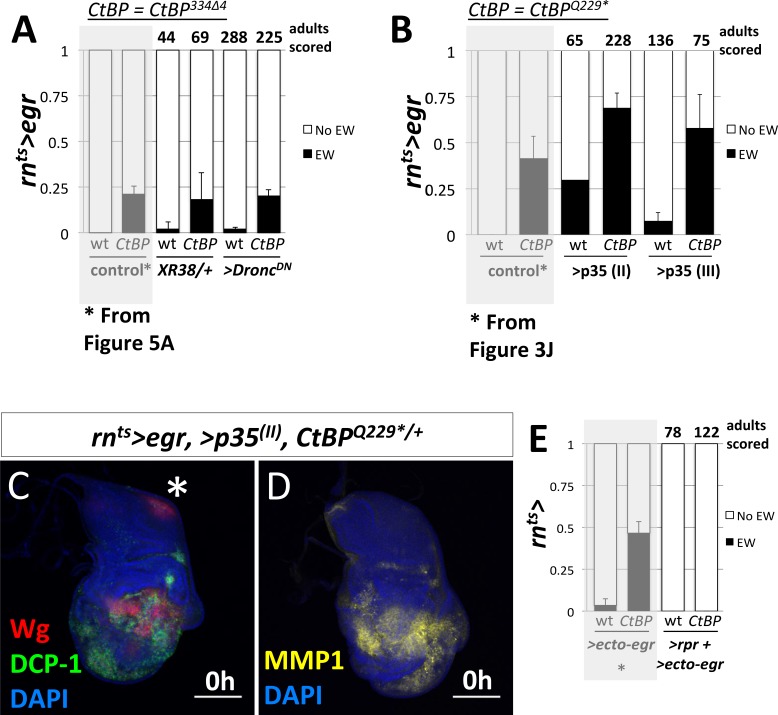
Manipulations of apoptosis levels during the damage period.(A) Frequency of ectopic wings (EW) following rnts>egr damage in wild type or CtBP334Δ4/+ in listed genotypes: (1) Df(3L)XR38/+ and (2) co-expression of UAS-DroncDN. Same controls as shown in Figure 5A. (B) Frequency of EW following rnts>egr damage in wild type or CtBPQ229*/+ with the co-expression of UAS-p35, by transgenes inserted on chromosome 2 and 3. Same controls as shown in Figure 3J. (C, D) Wing imaginal discs following rnts>egr damage with co-expression of UAS-p35. Note that there is still a high level of apoptosis (DCP-1), and Wg pattern disruption (C) and JNK activity visualized by anti-MMP-1 (D). (E) Frequency of EW following rnts>egr damage with co-expression of UAS-rpr and UAS-ecto-egr. Shown same data as Figure 5B to compare to UAS-ecto-egr alone.